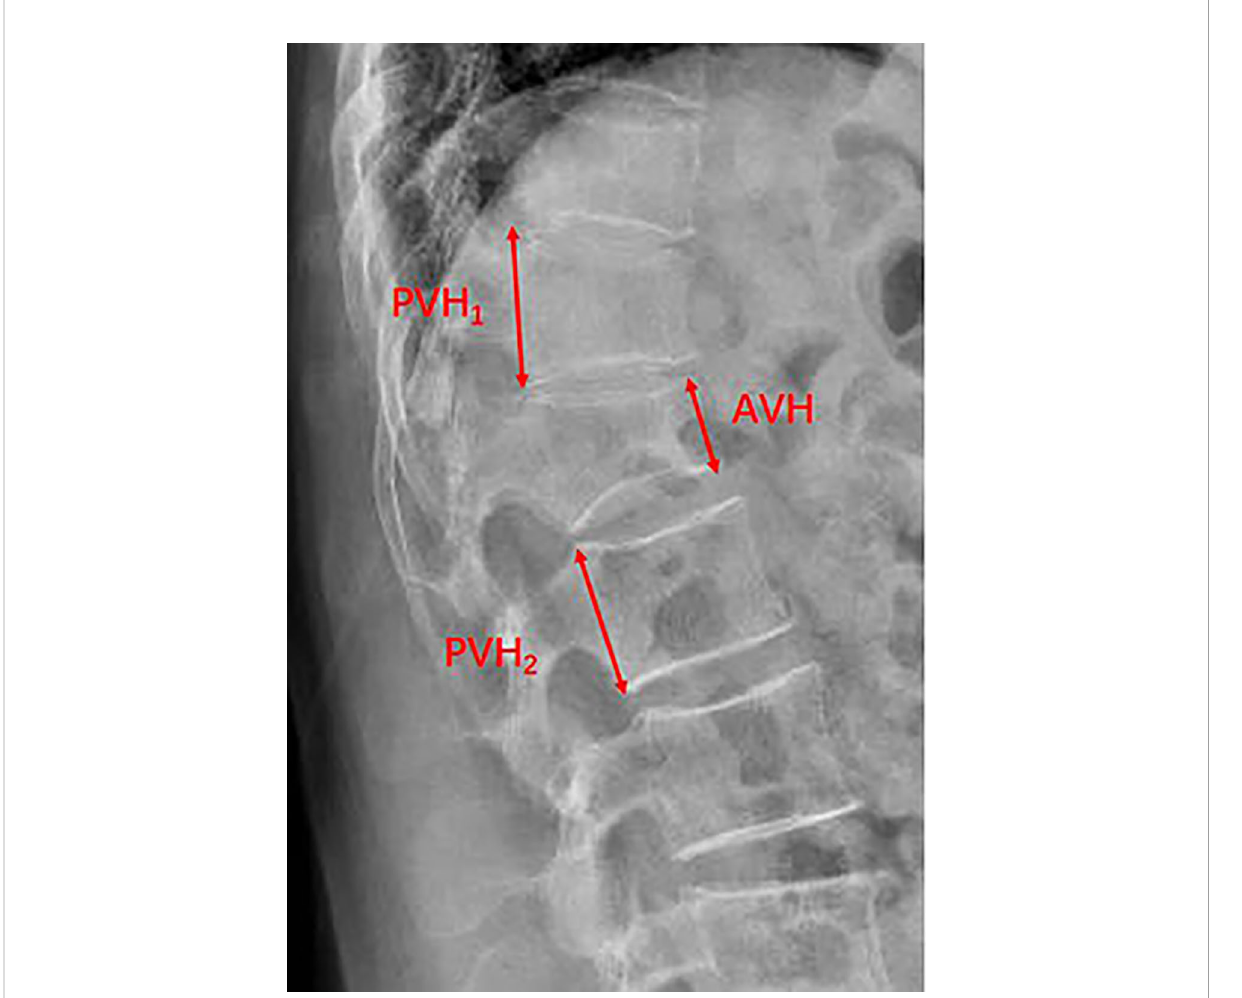
FIGURE 2 Plain radiograph showed the measurement of the anterior vertebral height (AVH) of the new fractured vertebral body, the posterior vertebral height (PVH 1 ) of the adjacent cranial vertebral body, and the posterior vertebral height (PVH 2 ) of the adjacent caudal vertebral